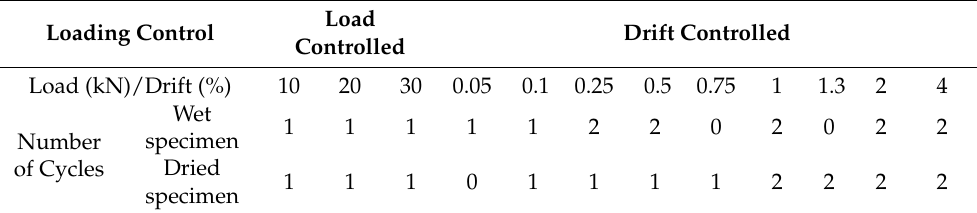
Table 4. Load application cycles.